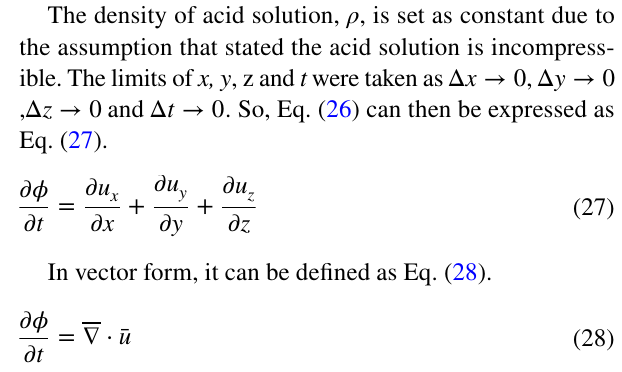
Fig. 21 The control volume of the acidizing